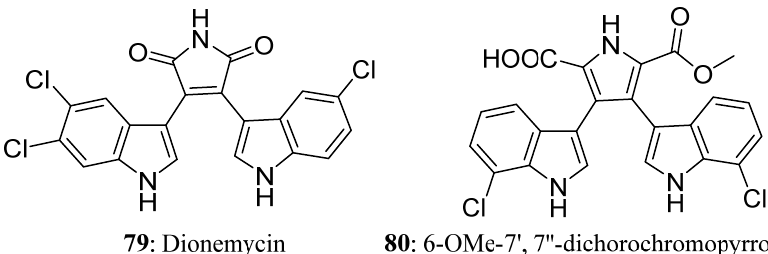
Figure 14. The structure of compounds 74 – 78 .